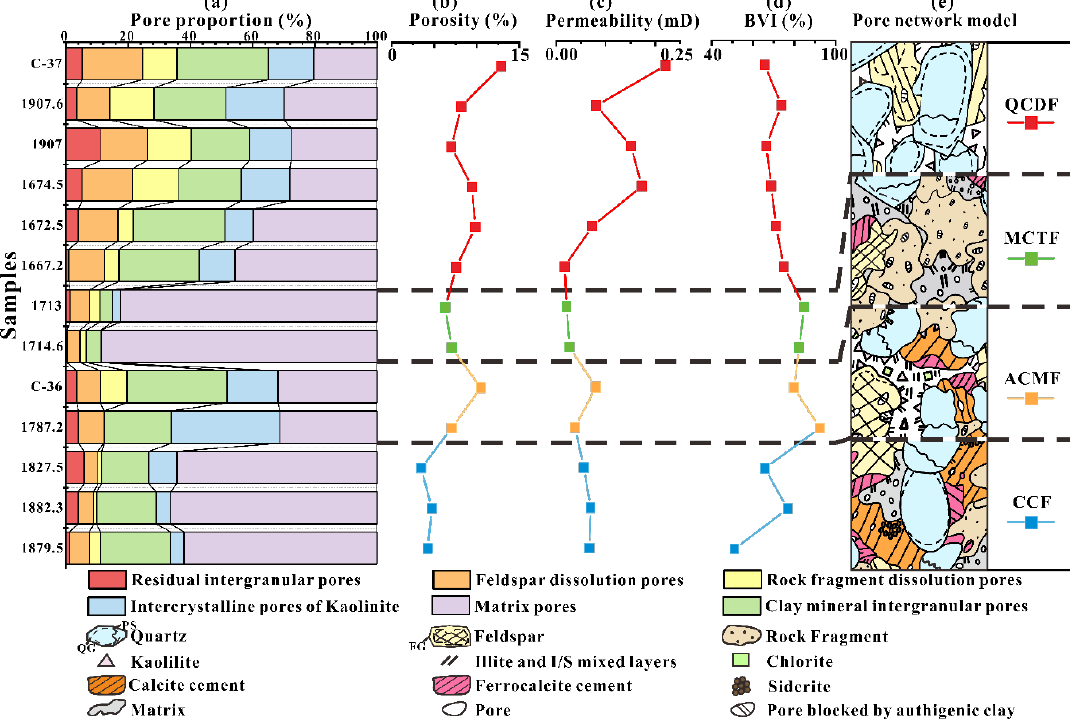
Figure 10. Impacts of the proportion distributions of different pore types in the four lithofacies. ( a ) Pore volume factions of six types of pores in 13 samples; ( b ) the variation in porosity, ( c ) the variation in permeability, ( d ) the variation in the proportion of immovable fluid (BVI) for 13 samples; and ( e ) pore network model of four lithofacies.